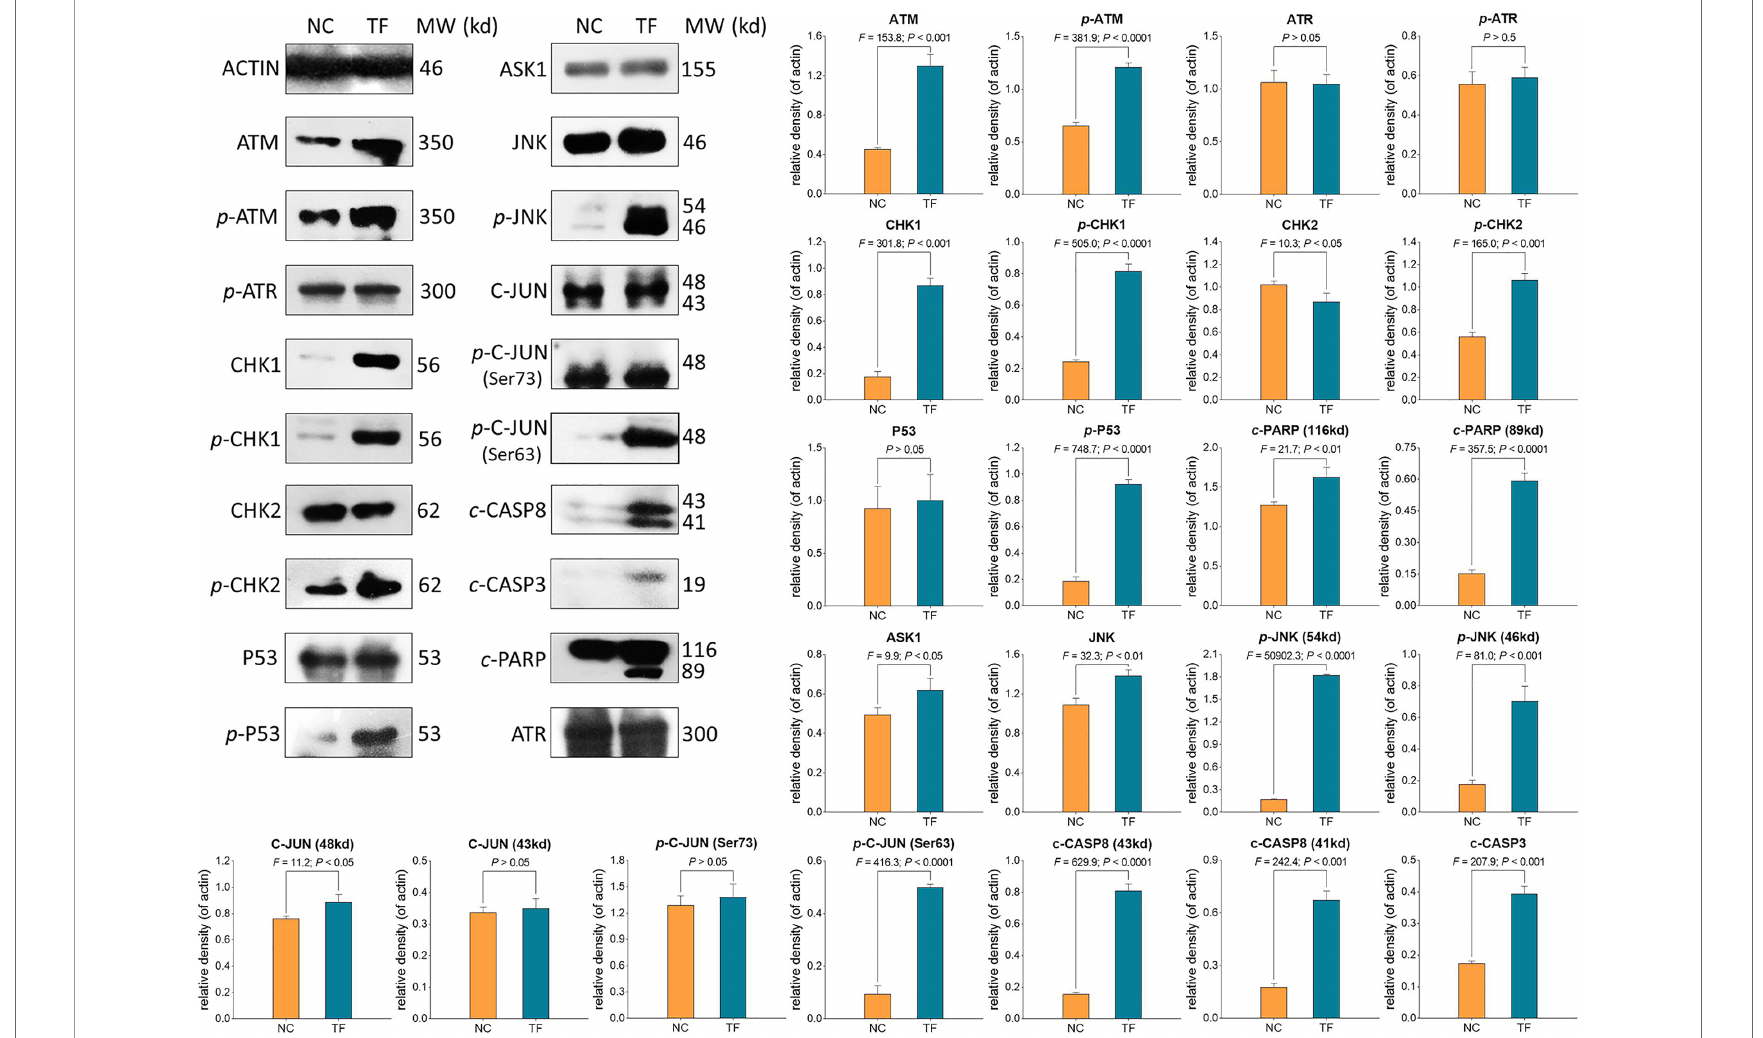
FIGURE 5 | Expression and phosphorylation of thea fl avin (TF)-targeted proteins in A375 cells after 24 h treatment. Data (mean ± SD) with different lowercase letters are signi fi cantly different with each other at Fisher ’ s least signi fi cant difference (LSD) multiple